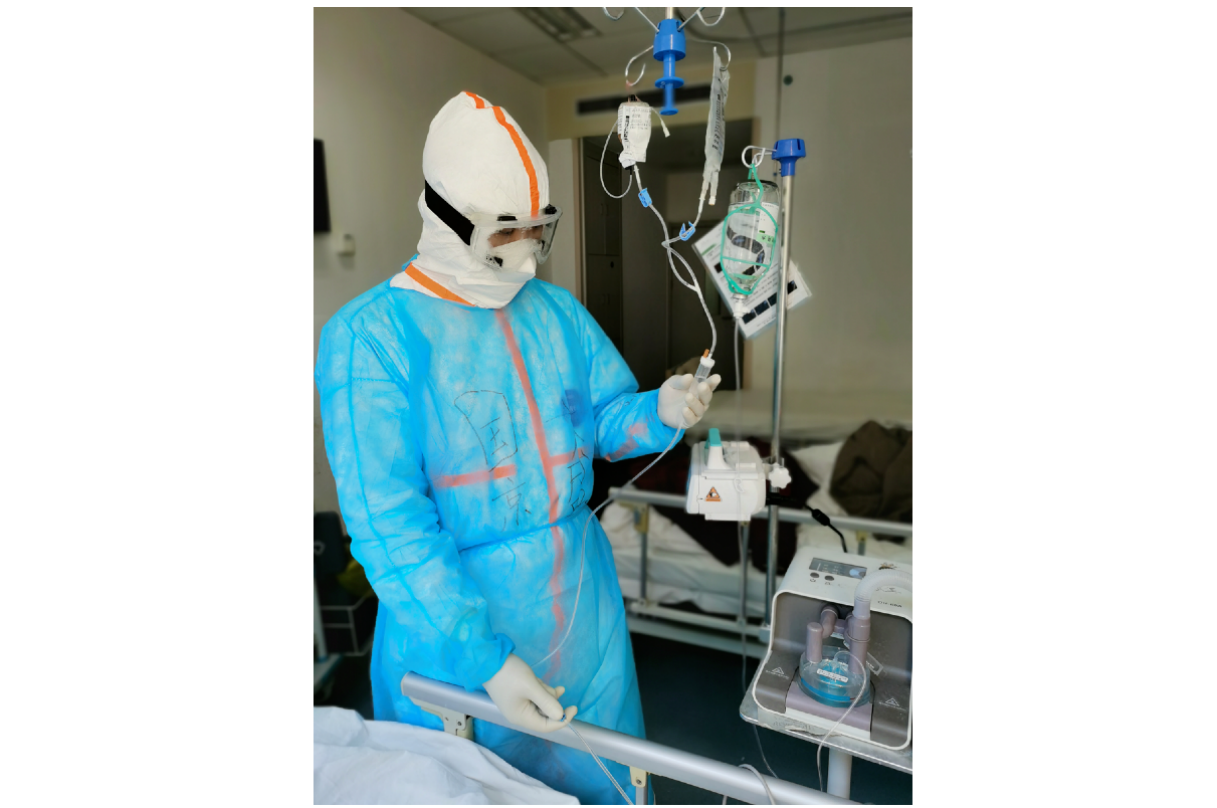
Figure 1. A medical staff member nursing a patient with COVID-19 in Wuhan, China. The staff member’s protective clothing prevents the use of a conventional